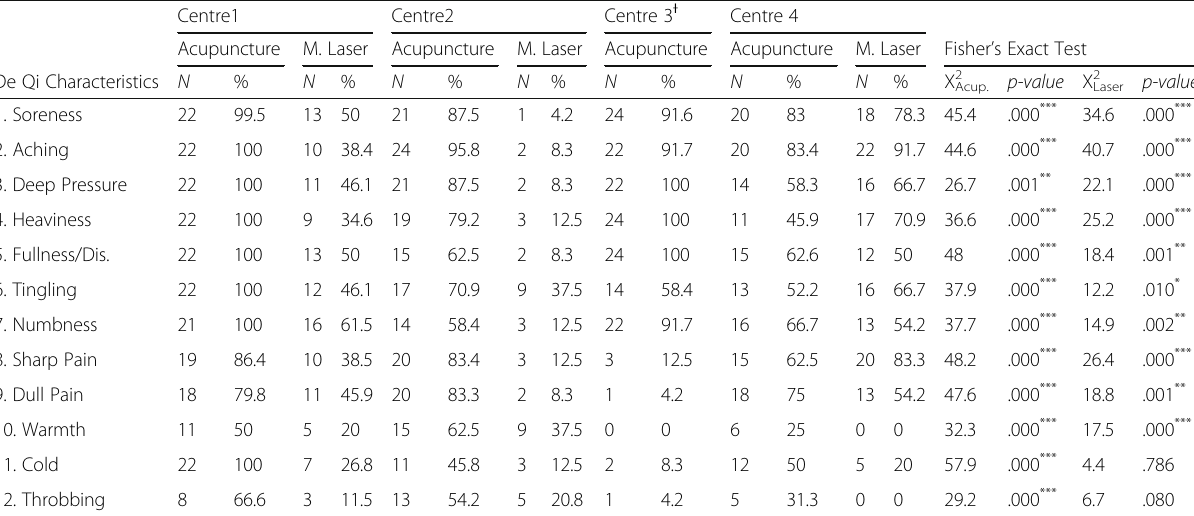
Table 3 Comparison of the individual De Qi characteristics across the study sites between the two study groups Centre1 Centre2 Centre 3 Ɨ Centre 4